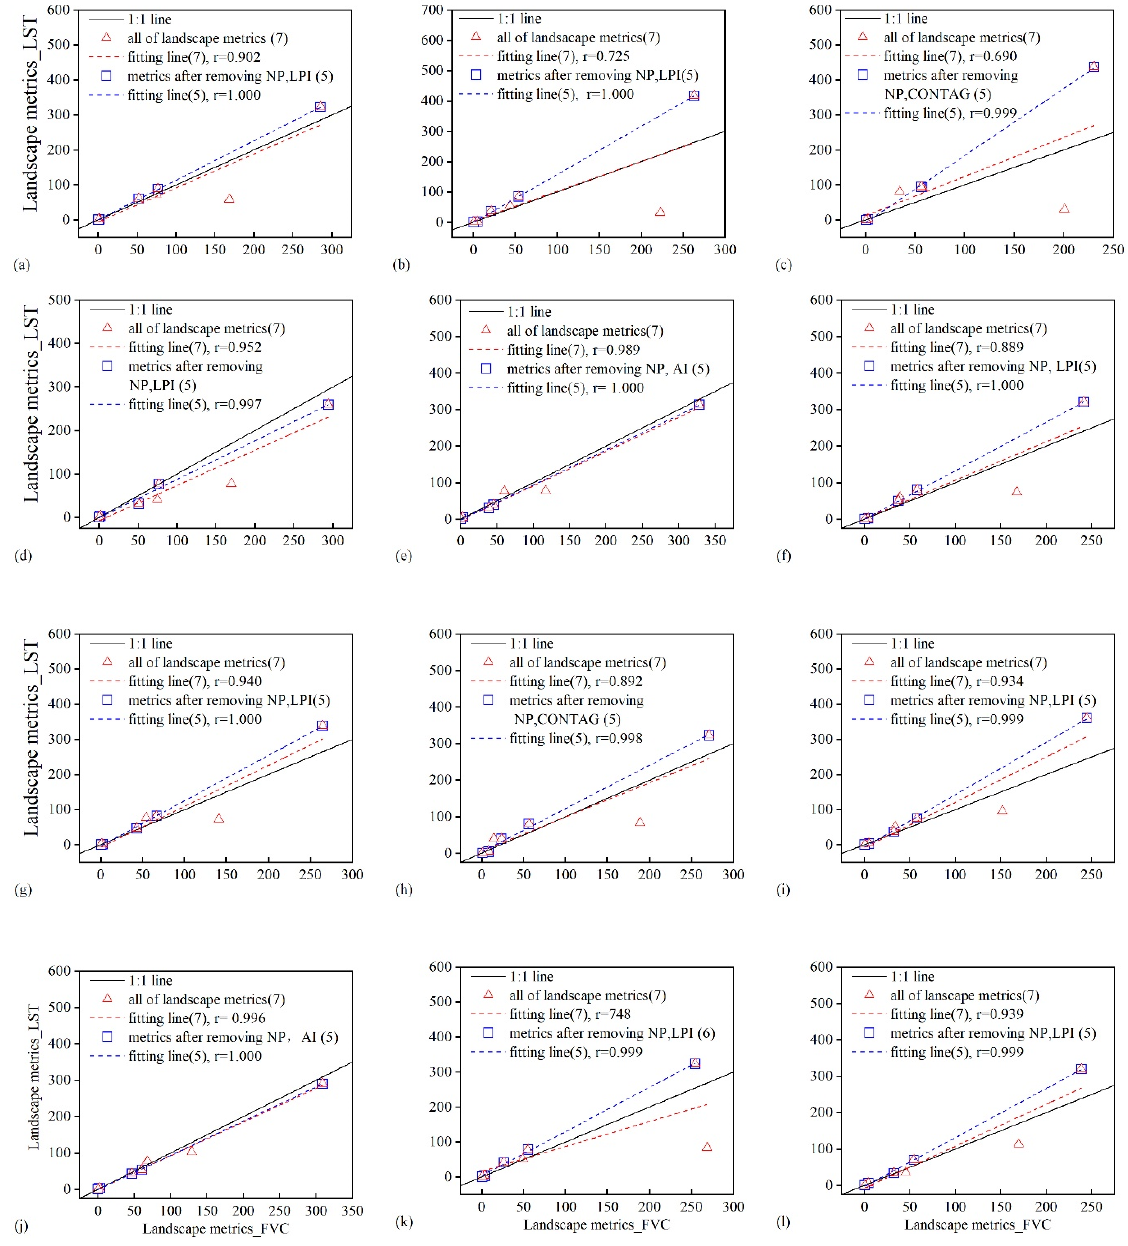
Figure 4. Relationship of landscape pattern metrics between FVC and LST at representative sample area (( a ), P1, S4; ( b ), P1, S2; ( c ), P1, S3; ( d ), P2, S4; ( e ), P2, S10; ( f ), P2, S3; ( g ), P3, S4; ( h ), P3, S5; ( i ), P3, S3; ( j ), P4, S4; ( k ), P4, S8; ( l ), P4, S3).